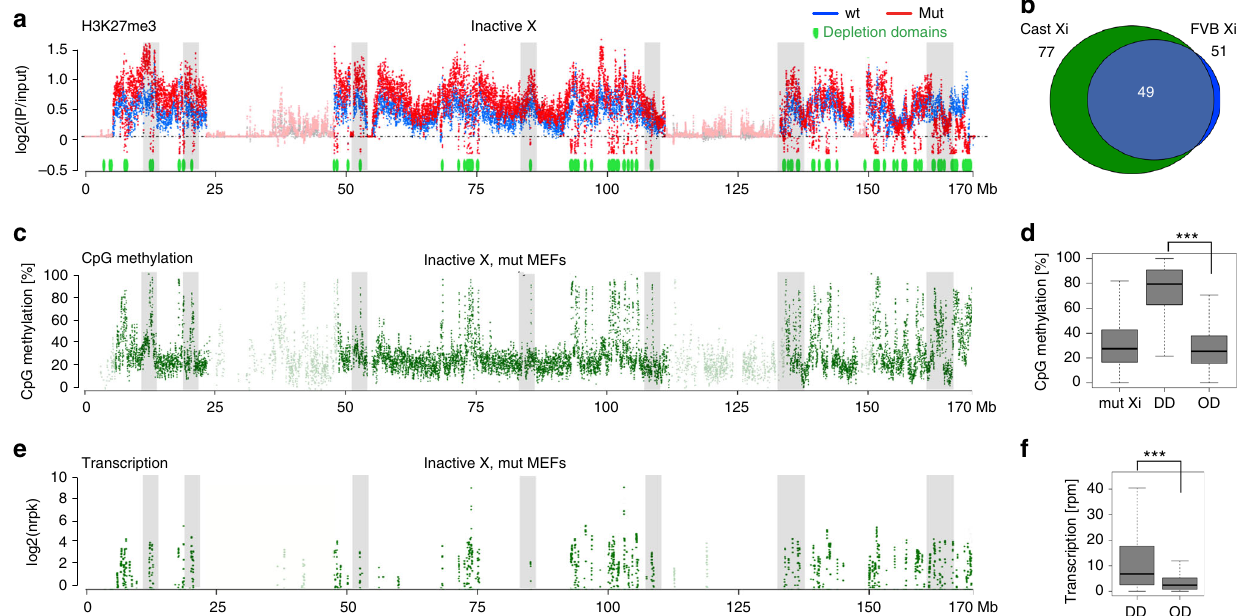
Fig. 3 H3K27me3 depletion highlights domains of Xi gene activation in SmcHD1 mutant MEFs. a Allele-speci fi c H3K27me3 ChIP-seq illustrating multiple H3K27me3 depleted domains not present on wt Xi. Scatterplot depicts ChIP log2(IP/input) values averaged within 10 kb bins. 77 H3K27me3 depleted domains are plotted in green below the H3K27me3 pro fi le. Regions of low probe mappability are indicated with reduced transparency. b Overlap between H3K27me3 depletion domains detected in the germline SmcHD1 mutant (mut) mut5 A6 clone used throughout the study with Xi derived from M.m. castaneus (Xa from FVB strain) with different MEF cell line mut5 E1 coming from different parents and with Xi from FVB (Xa from M.m.castaneus). Location of H3K27me3 depleted domains on Xi in mut MEFs correlates with, CpG hypermethylation domains ( c , d ) and genes activated on Xi ( e , f ). Signi fi cance of differences in DNA methylation level ( d ) and transcription ( f ) in the domains depleted of H3K27me3 and the rest of the chromosome was estimated with Mann – Whitney *** p -value < 10 -4 . Grey shading in a , c , e highlights the correlation between H3K27me3, CpG methylation and transcription at the representative examples of loci depleted of H3K27me3. Boxplots in d , f present quartiles, median and outliers NATURE COMMUNICATIONS| (2019) 10:30